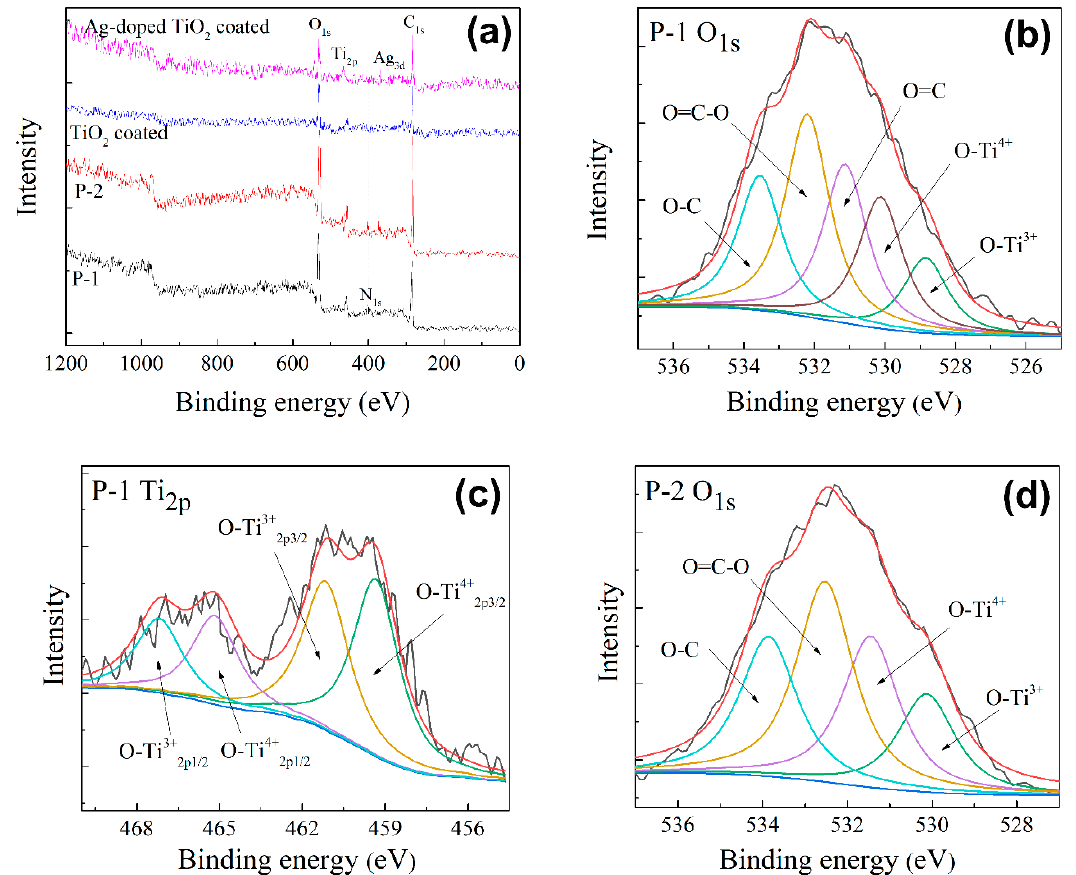
Figure 5. ( a ) Photocurrent response ( i – t ) curves, ( b ) electrochemical impedance spectroscopy (EIS) Nyquist plots, ( c ) steady-state PL spectra and ( d ) time-resolved transient photoluminescence (PL) decay spectra of the P–1 and P–2 filaments ( λ (E x ) = 340 nm). Table 2. Fitting parameters of the time-resolved PL data using two-exponential decay kinetics.